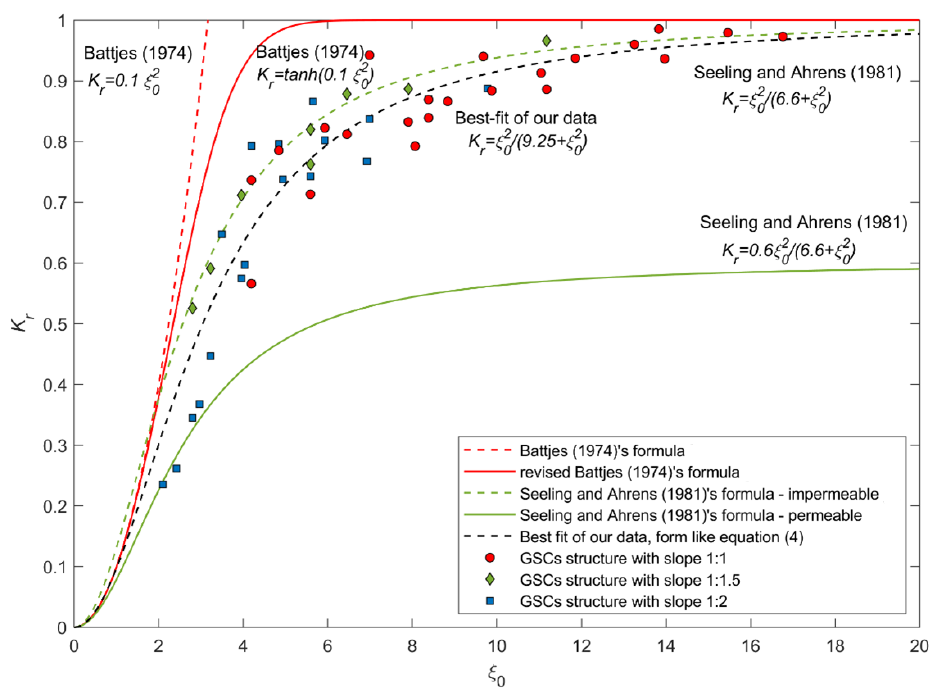
Figure 10. Comparison of our experimental data and reflection coefficient K r formula given in the literature [4,10]. literature